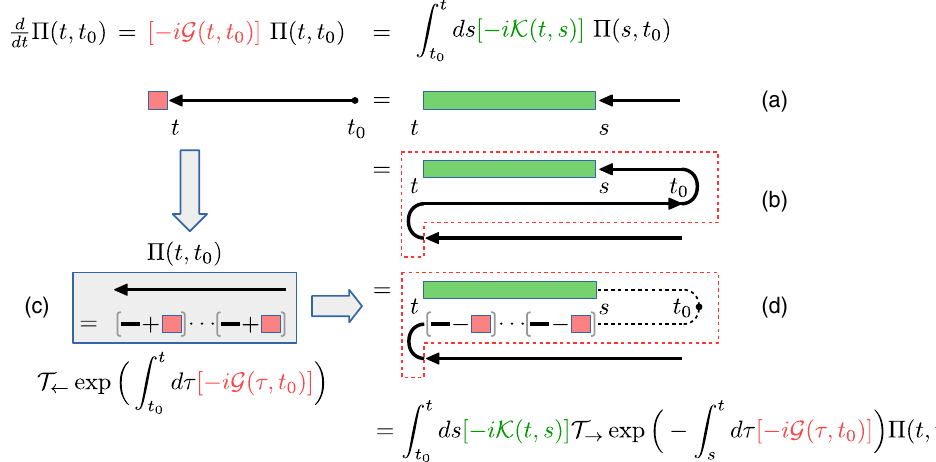
FIG. 1. Graphical representation of the derivation of the functional fixed-point equation (10). (a) Equivalent expressions for d Π ð t; t 0 Þ =dt as given by the two QMEs. (b) Insertion of canceling backward and forward propagation to initial time t 0 . (c) Evolution R T I − i G ð t Δ t … ½ I − i G ð t Δ t t d τ ½ − i G ð τ ; t 0 Þ(cid:2)g ¼ lim expressed as product of infinitesimal steps for the sake of ← exp f 1 Þ 1 (cid:2) N → ∞ ½ N Þ N (cid:2) t 0 illustration. (d) Backward propagation to memory time s expressed in terms of G using the divisor. The self-consistency expressed by the functional fixed-point equation (10) arises from backward propagation that is needed to enforce the time-local structure of QME (2) onto the QME (1). For time-translational systems in the stationary limit the generator becomes G ð τ ; t 0 Þ → G ð ∞ Þ and literally takes on the role ˆ K of the complex frequency at which ð ω Þ is sampled in Eq.